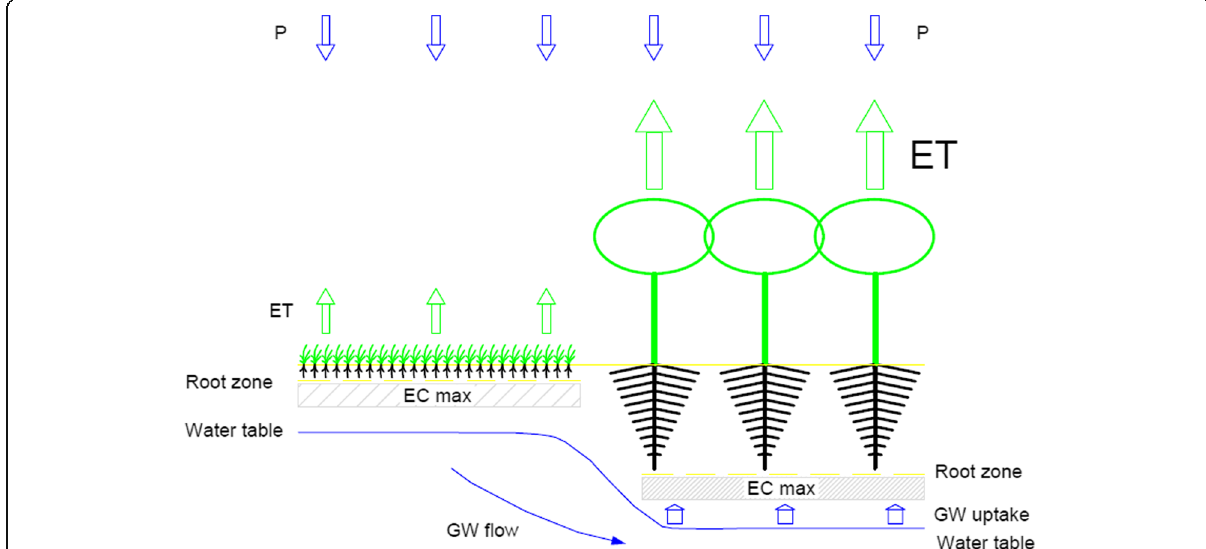
Fig. 1 Forest vegetation impact on water-salt balance in a shallow groundwater environment, after Szabó et al. (2012). ET evapotranspiration, P precipitation, EC electrical